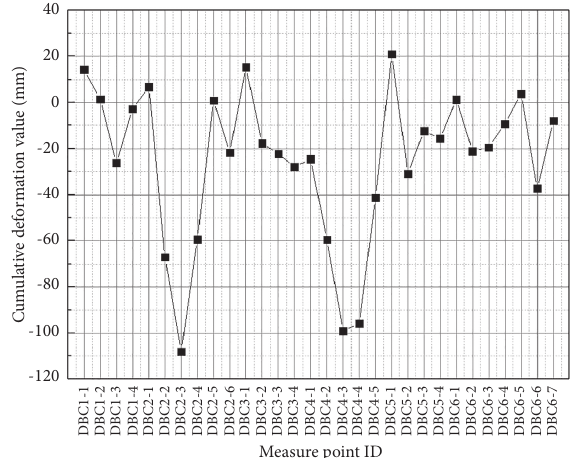
Figure 22: Cumulative deformation of surface